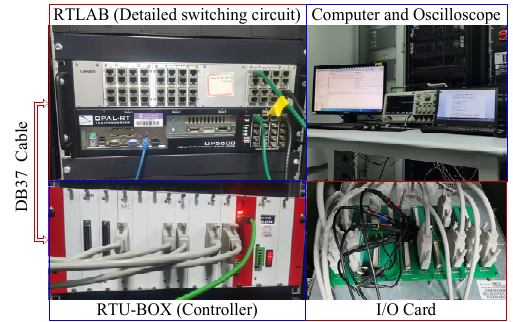
Figure 12. The experimental platform of the studied MMC system.